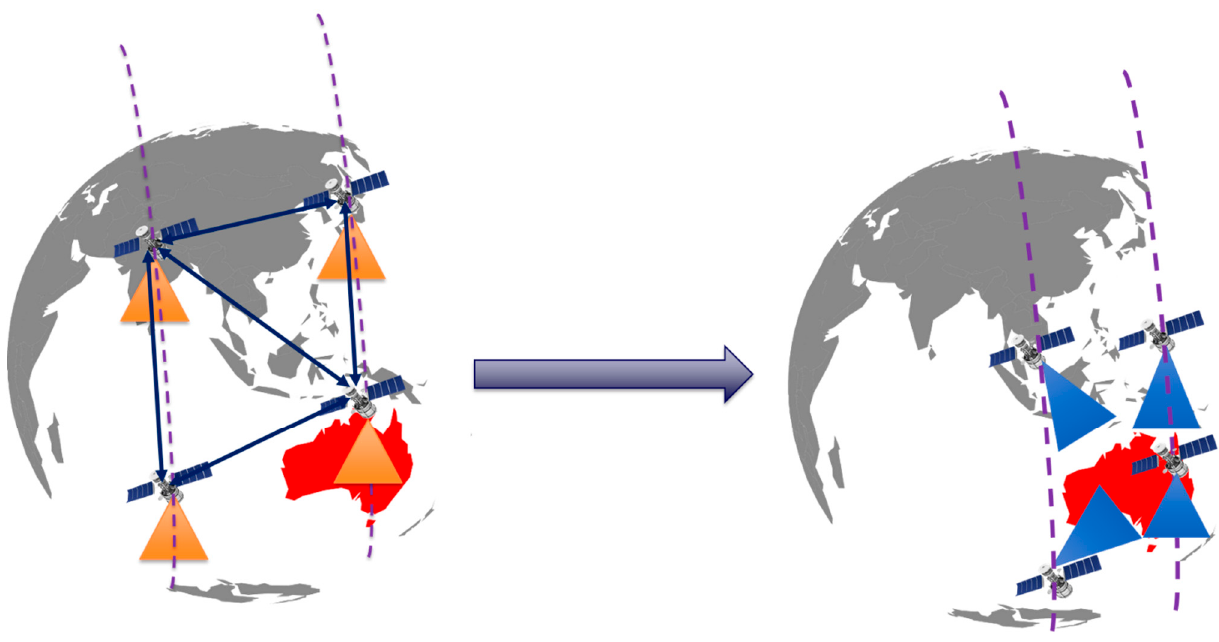
Figure 7. Wildfire segmentation map of the hyperspectral imagery over Australia [56].